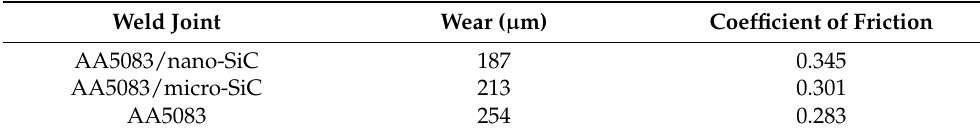
Table 3. Wear behaviors of the SFSSW joints with and without the addition of SiC particles. Weld Joint Wear ( µ